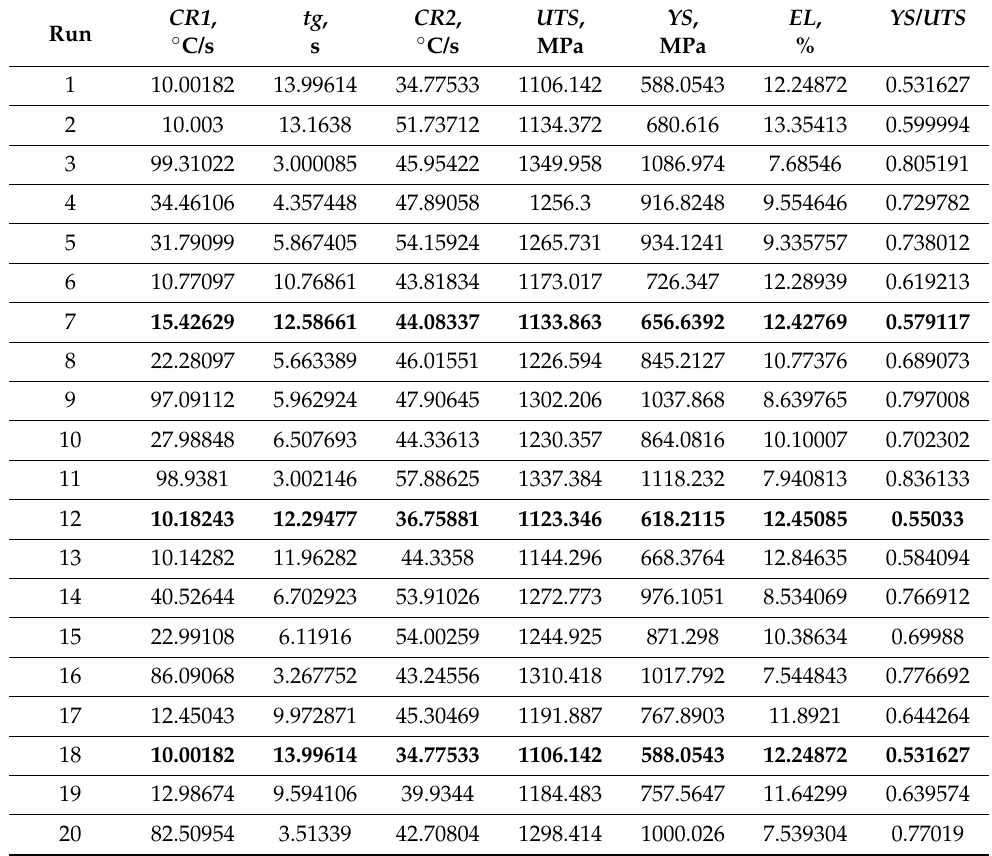
Table 3. Optimal Solutions. Thermal cycles for experimental validation (run 7, 12 and 18).